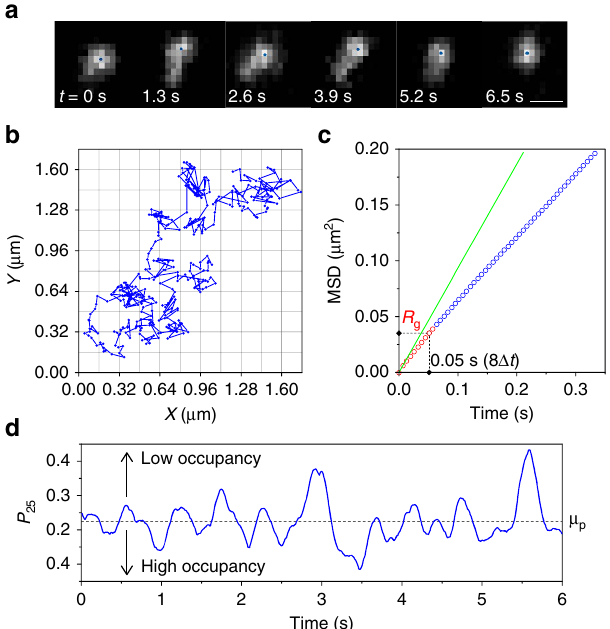
Figure 2 | Single-molecule tracking and analyses of ColE 1 DNA. ( a ) Time lapse fluorescence images of a single DNA molecule. The blue circles show the 2D positions of the molecule determined by the tracking. Scale bar ¼ 1 m m. ( b ) Diffusion trajectory of ColE 1 DNA mapped onto the latticed 2D space with 0.16 m m side length of the lattice (See Supplementary Note 1). ( c ) MSD- D t profile of ColE 1 DNA ( D t ¼ 6.4ms). R g shows the radius of gyration of ColE 1 DNA. The red and blue circles highlight the parts of the MSD- D t profile that show sub-diffusive and linear-diffusive regimes. The green line is the theoretical MSD- D t profile. ( d ) Temporal P 25 profile of ColE 1 DNA. m p shows the mean P 25 value.